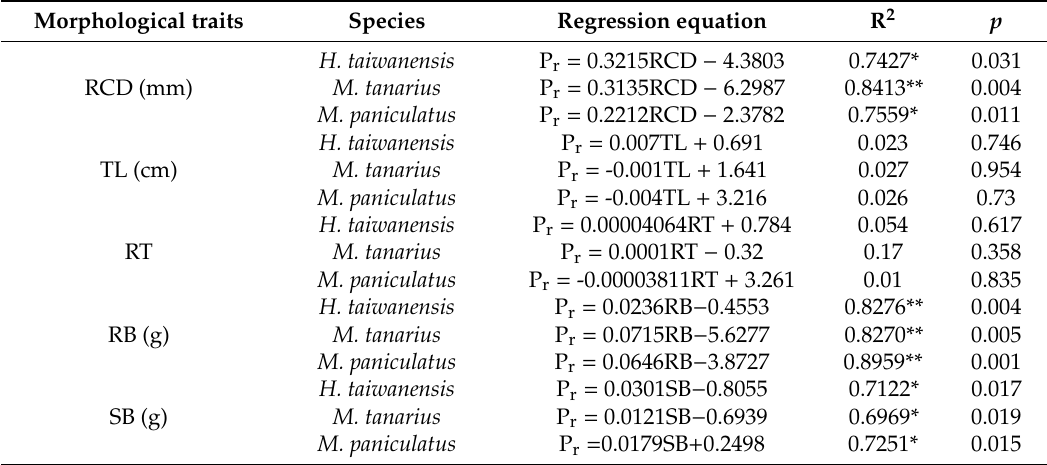
Table 6. Relation between root traits and pullout resistance for the three species studied. Morphological traits Species Regression equation